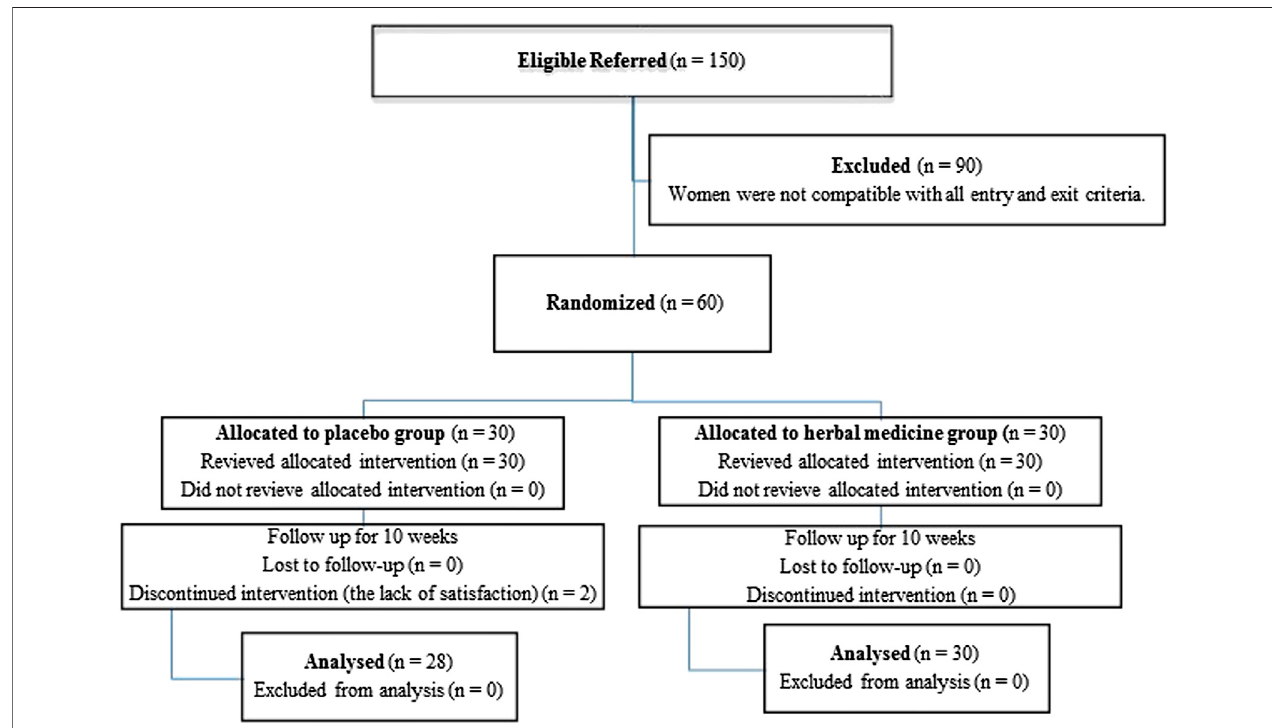
FIGURE 1 | Flow chart for the participants ’ enrollment, randomization, and retention. Participants in the herbal medicine and placebo groups received 15 g/day of E. angustifolia L. fruit powder and (7.5 g corn starch + 7.5 g isomalt)/day, respectively.